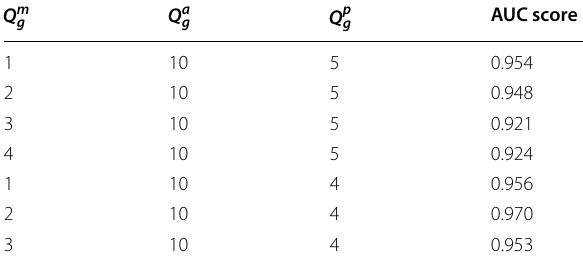
Table 12 AUC scores of TGV (or T ) under different combinations 2 of gradient magnitude, gradient azimuth and gradient polar angle using leave-one-out cross validation